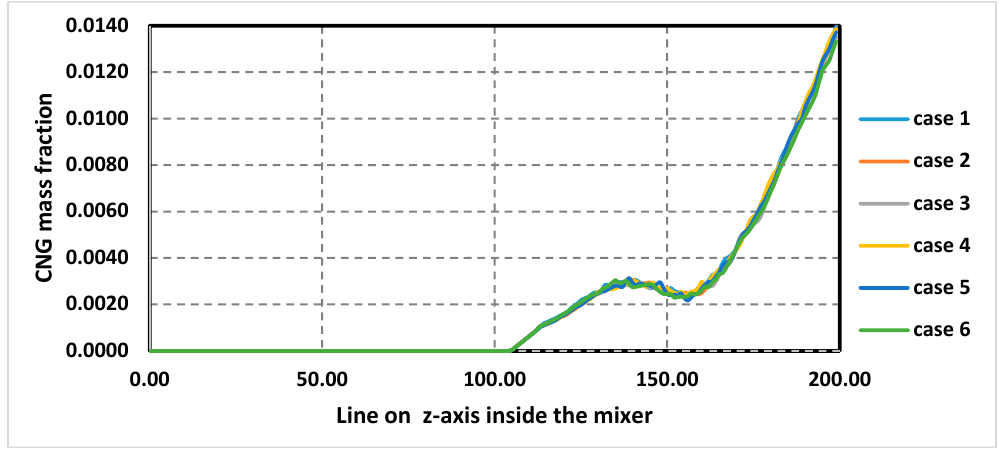
Figure 7. CNG mass fraction on line along x -axis inside mixer outlet (model1), grid independence test results.